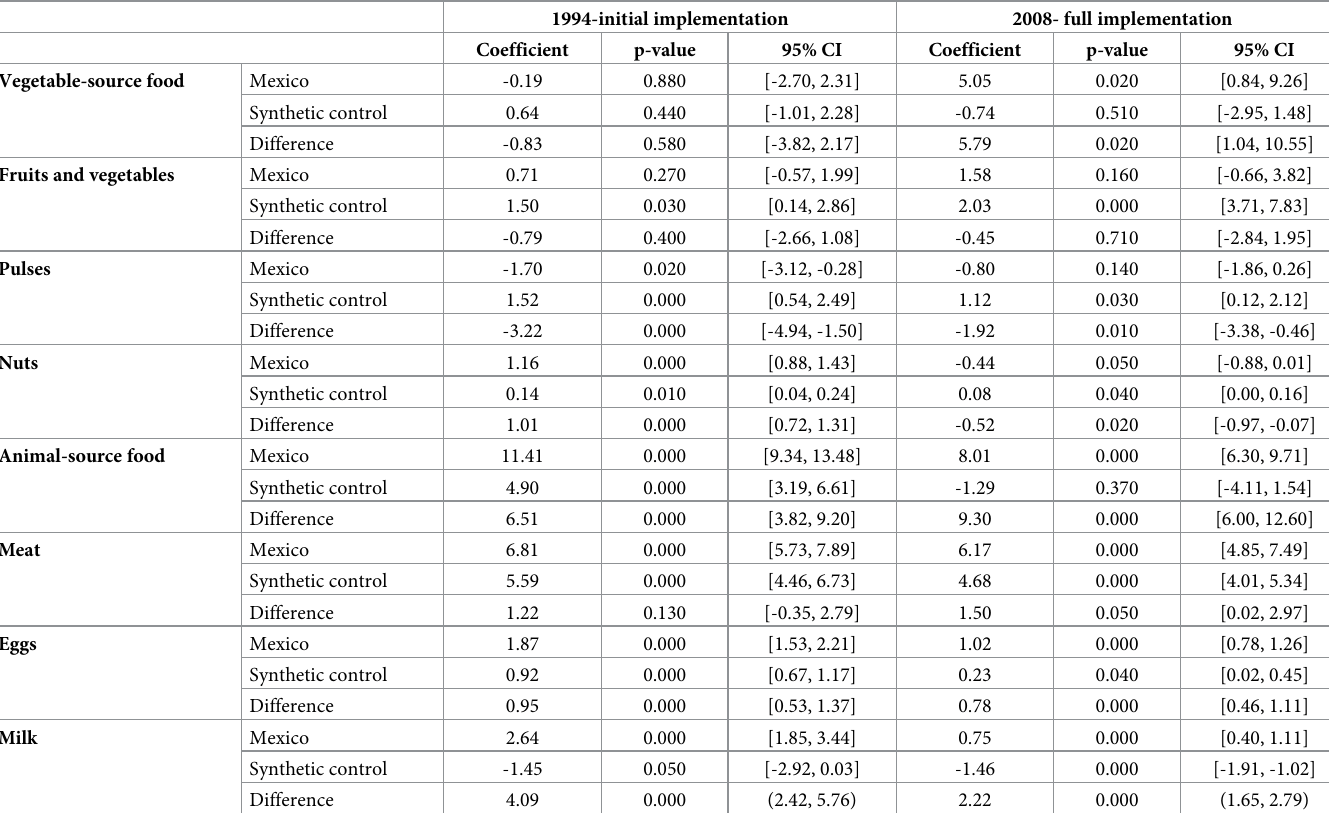
Table 3. Post 1994 and 2008 intervention trends of stable food apparent consumption (kcal/capita/day), comparing Mexico and the synthetic control